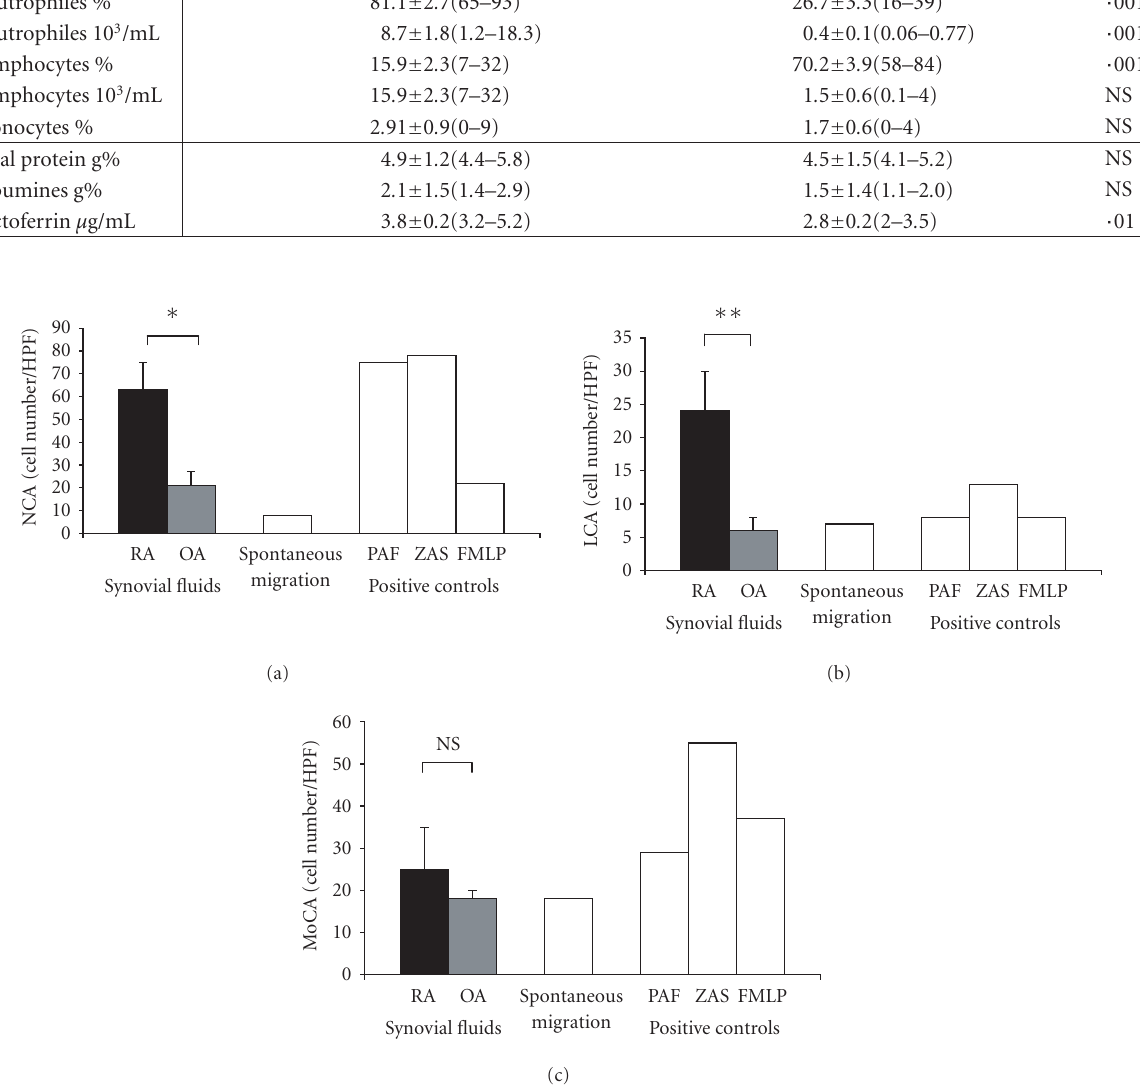
Figure 1. (a) Synovial fluids from patients with RA reveal high chemotactic activity for neutrophils (NCA). Rheumatoid SFs show remarkably stronger NCA as compared to OA SF; mean values ± SEM are presented, ∗ P ≤ . 05. (b) Synovial fluids from patients with RA show high chemotactic activity for lymphocytes (LCA). SFs from patients with OA do not induce chemotaxis of lymphocytes; mean values ± SEM are presented, ∗∗ P ≤ . 01 . (c) Synovial fluids from patients with RA show slight chemotactic activity for monocytes (MoCA) while synovial fluids from patients with OA do reveal MoCA. No di ff erence in MoCA between RA and OA SF has been detected; mean values ± SEM are presented; NS: not